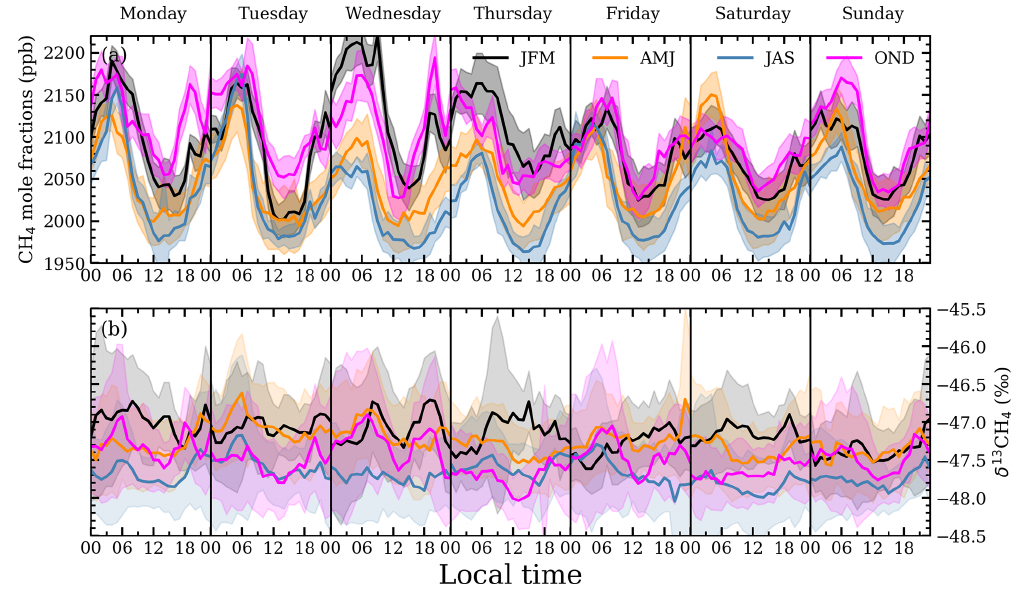
Figure 6. Weekly detrended 20min averages of (a) mole fractions and (b) δ 13 CH 4 at ICL (values normalized to 1 March 2018 and 1 May 2019, t ref , respectively). Measurements are grouped by season of year and binned by hour of day and day of week. The 1 σ range is included on both panels.